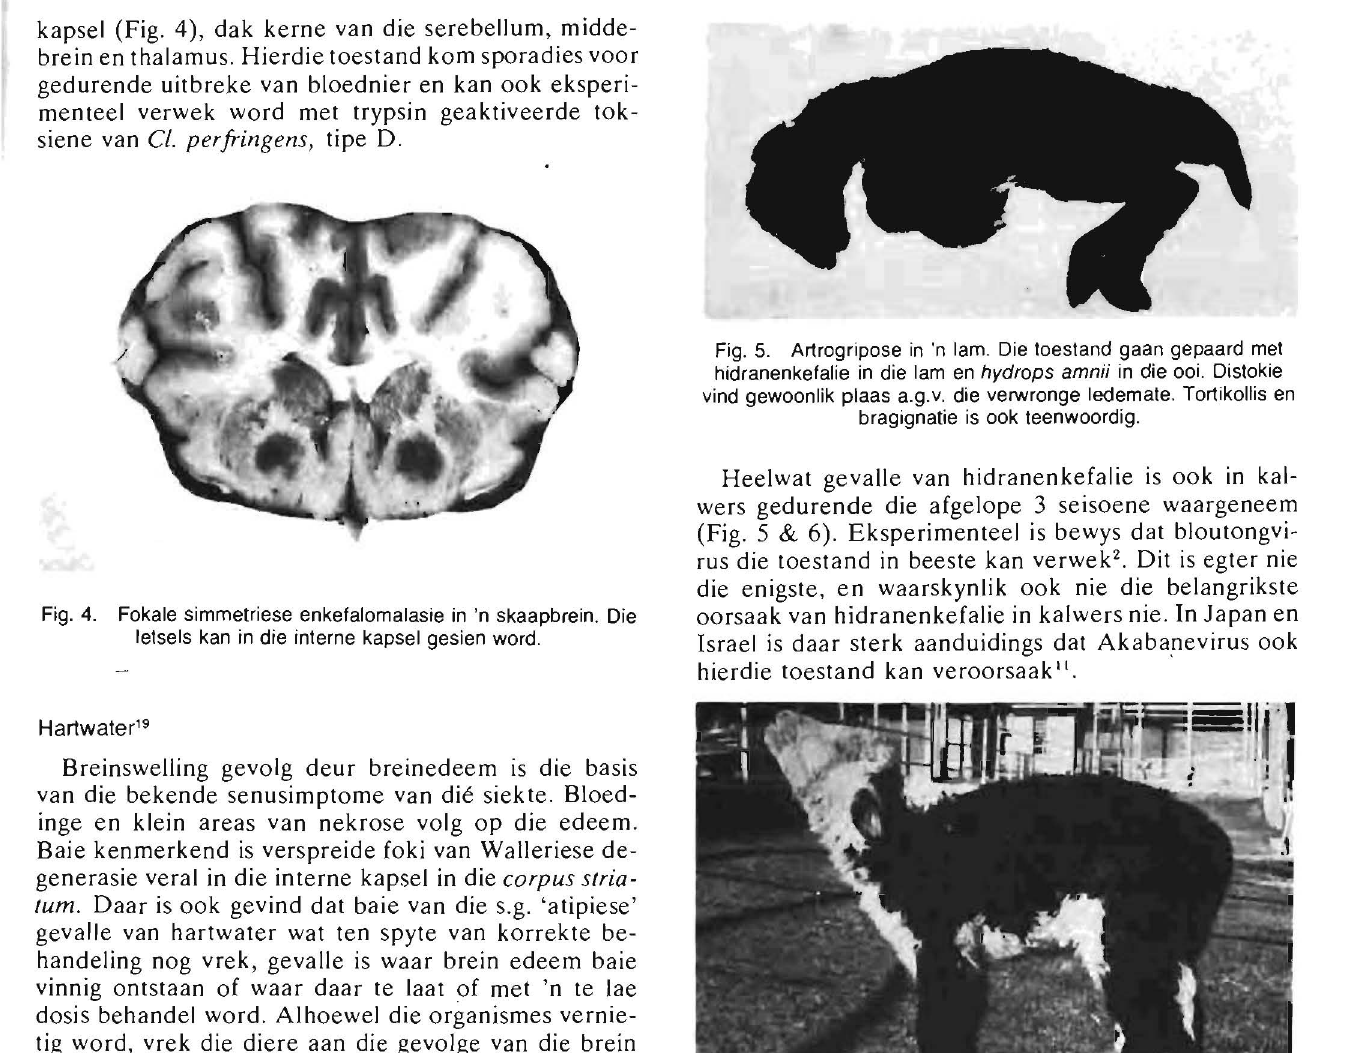
Fig. 7. Hidranenkefalie in 'n kalf. Geen serebrum is teenwoordig nie. Dit is vervang met vloeistof wat hier uitgeloop het nadat die breinvliese stukkend gesny